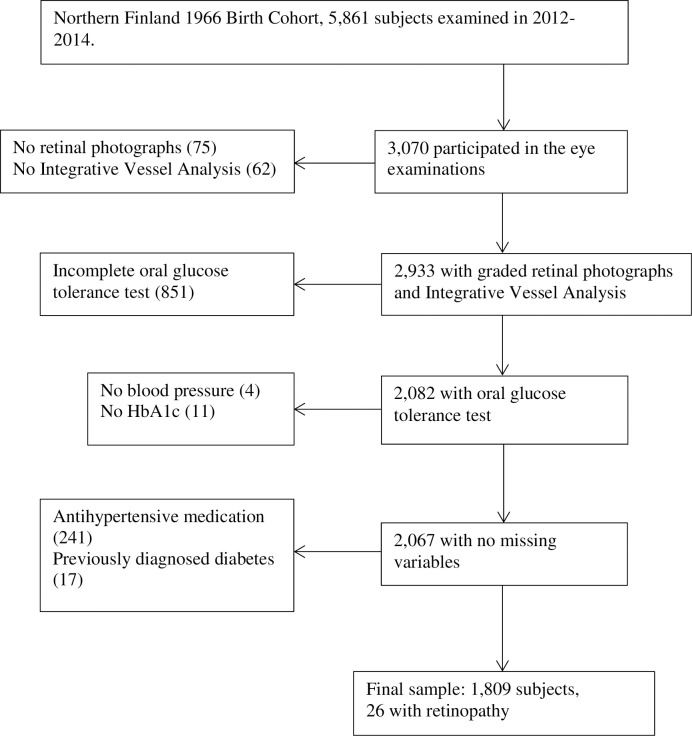
Flowchart of the Northern Finland Birth Cohort 1966 study.